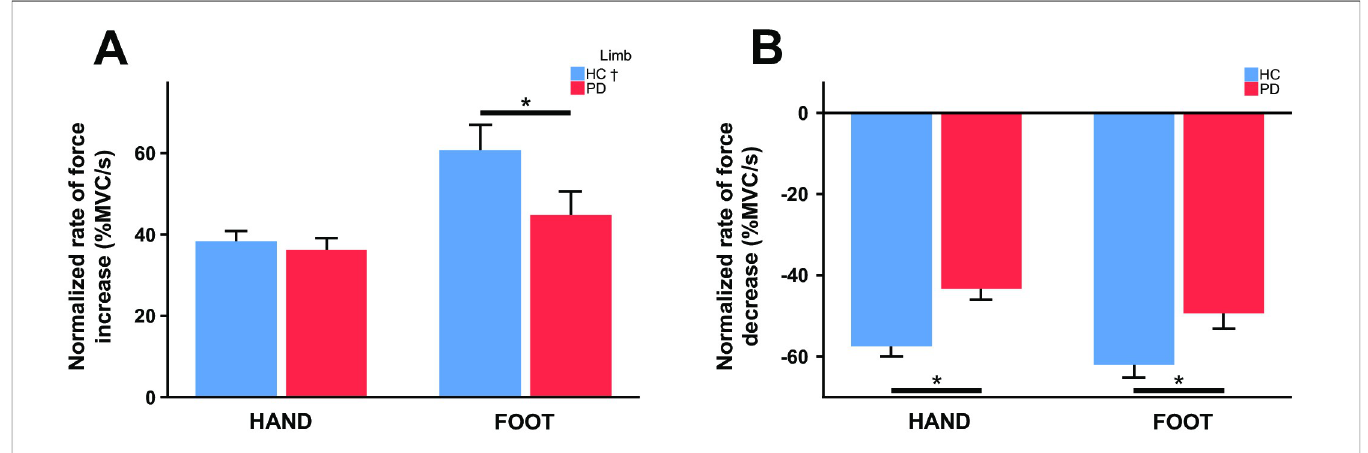
Fig 3. Bar graphs represent task performance for each group and limb (mean ± 1 SE). (A) Normalized rate of force increase, (B) normalized rate of force decrease. Asterisks indicate significant group effects at p < 0.05. Obelisks indicate significant limb effects at p < 0.05. Abbreviations: HC = healthy controls, PD = Parkinson’s disease.